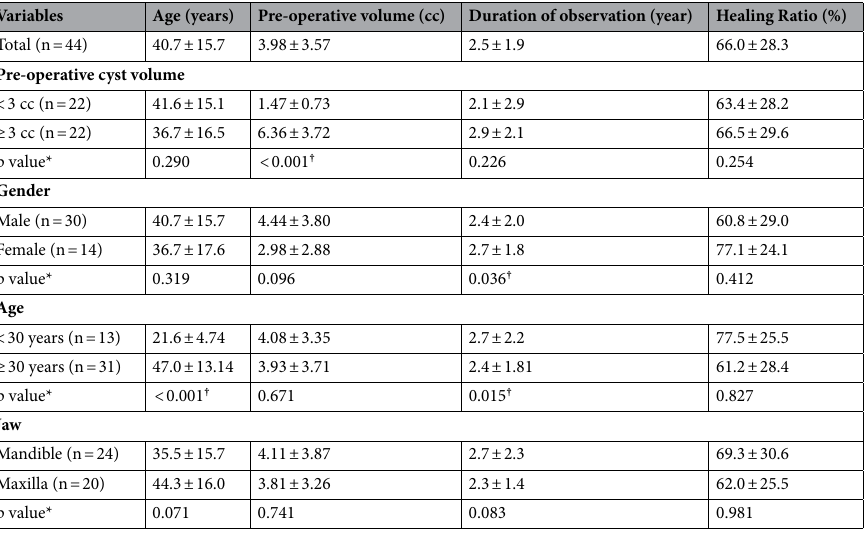
Table 1. Volumetric analysis for spontaneous bone healing after cyst enucleation. *Mann–Whitney U test. † p value <